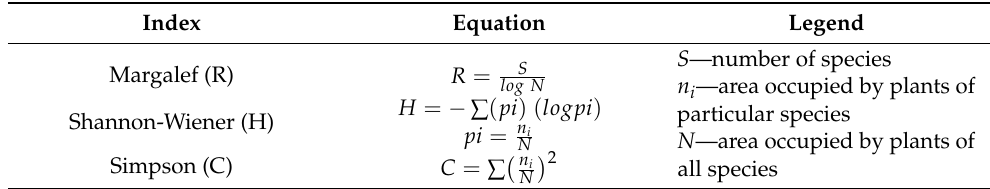
Table 1. Ecological indexes.